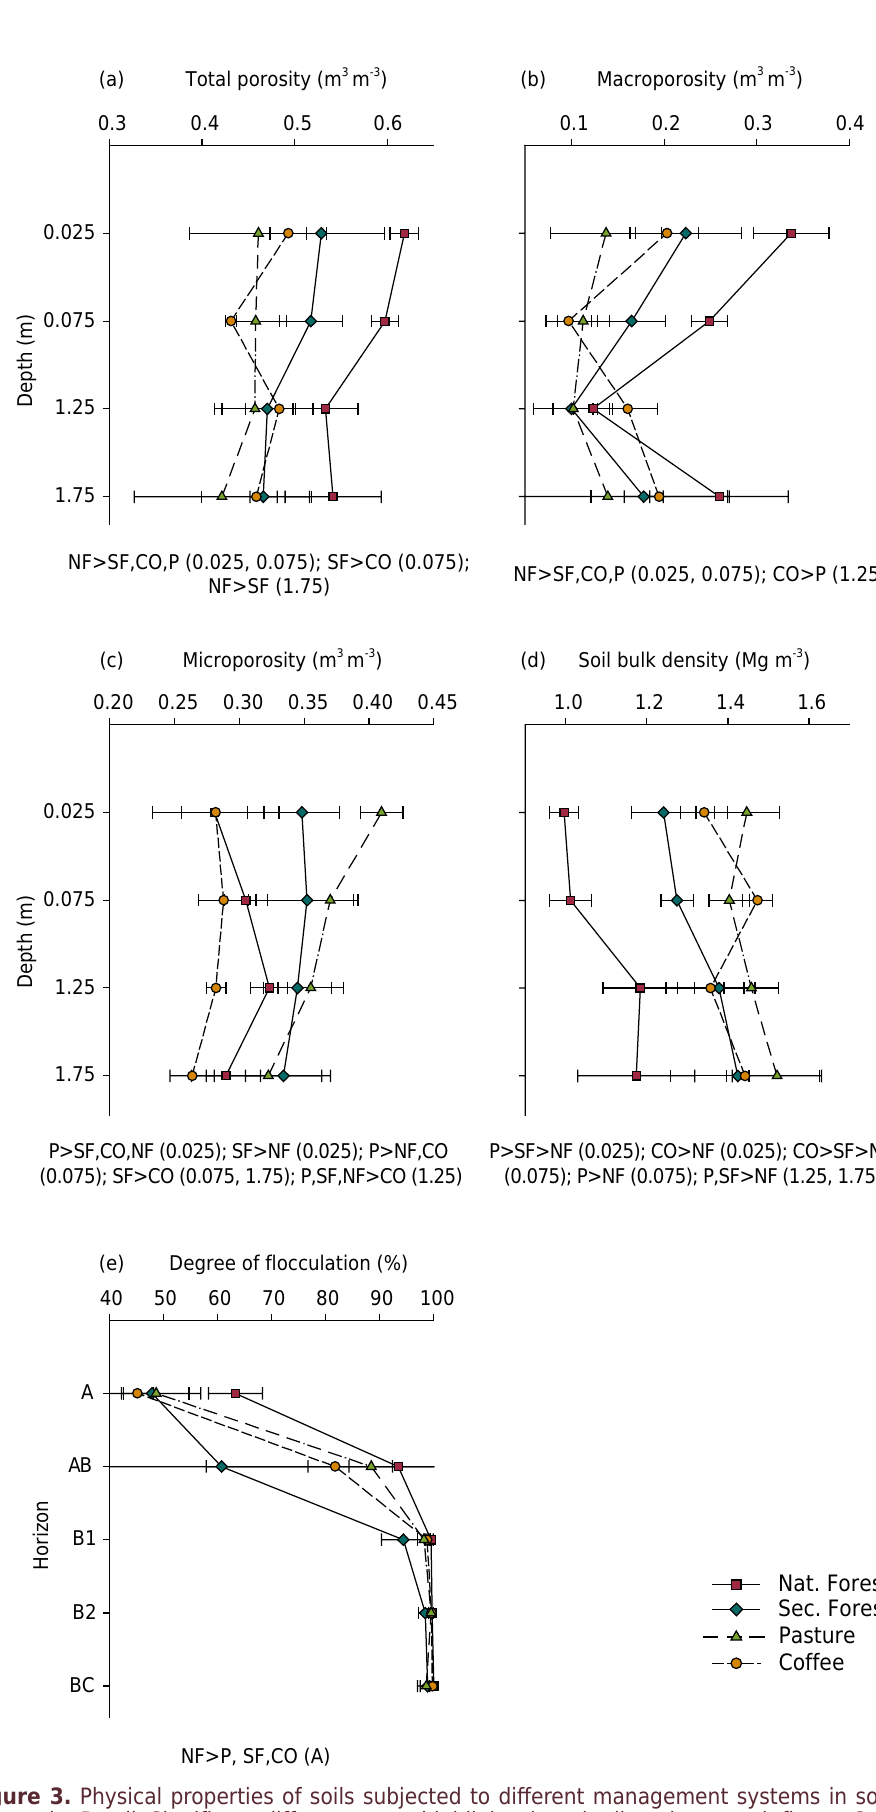
Figure 3. Physical properties of soils subjected to different management systems in southern Amazonia, Brazil. Significant differences are highlighted on the line above each figure. Standard deviation is represented in horizontal